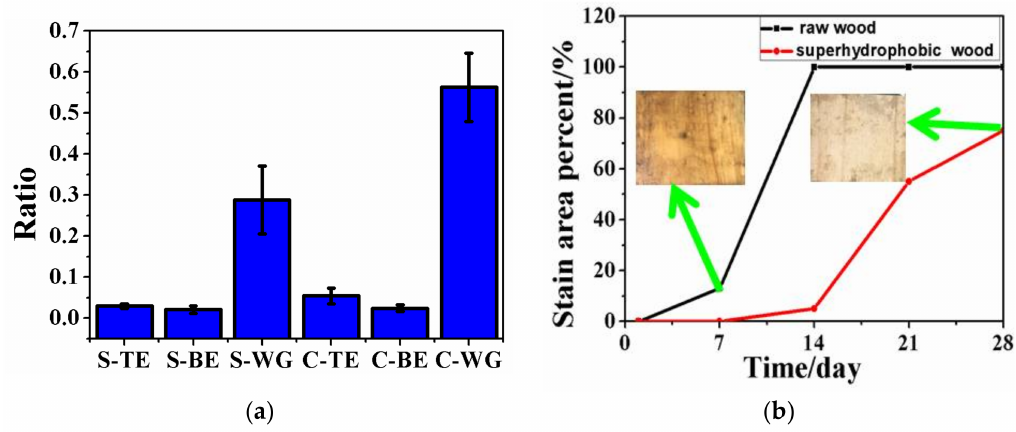
Figure 8. ( a ) The ratio of thickness expansion (TE), breadth expansion (BE), and weight growth (WG) for wood where S and C stand for superhydrophobic wood and control raw wood; ( b ) Mildew